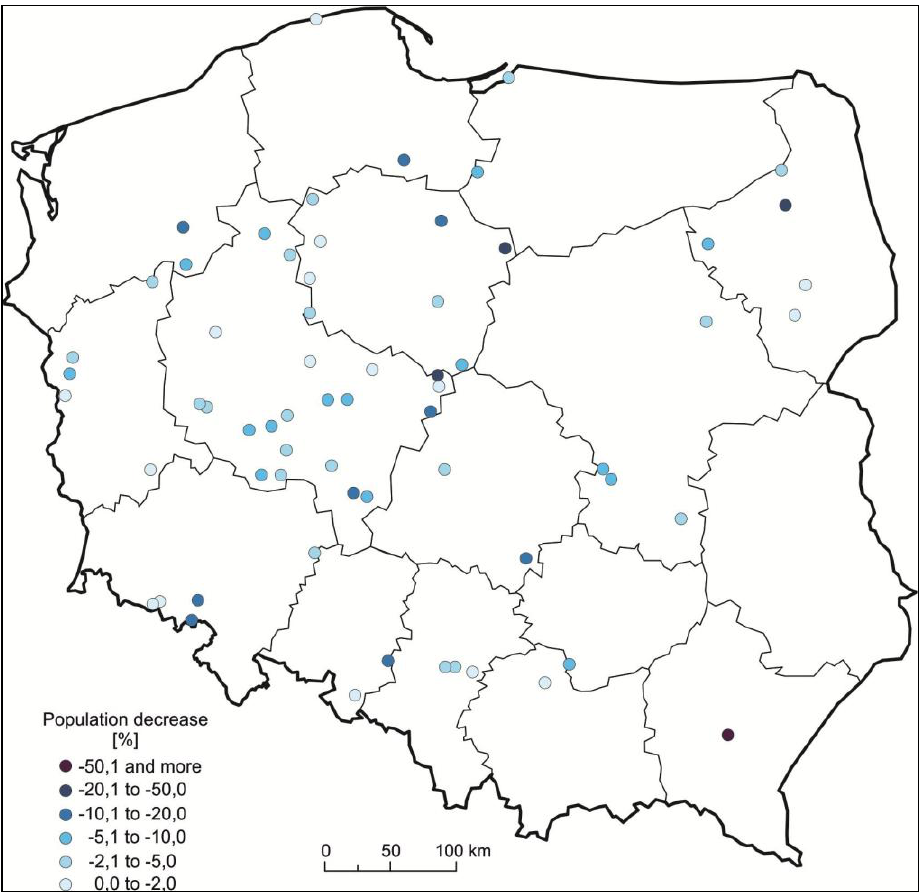
Fig. 3. Population decrease in towns of Poland, 1960-1970 (by author on the basis of Annex 2: Kantor-Pietraga,